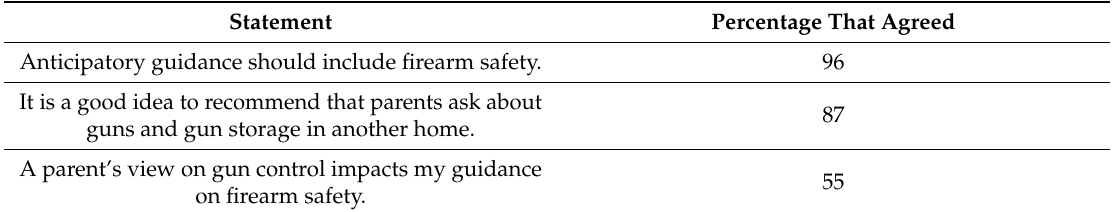
Table 4. Residents’ attitudes toward firearm safety counseling.